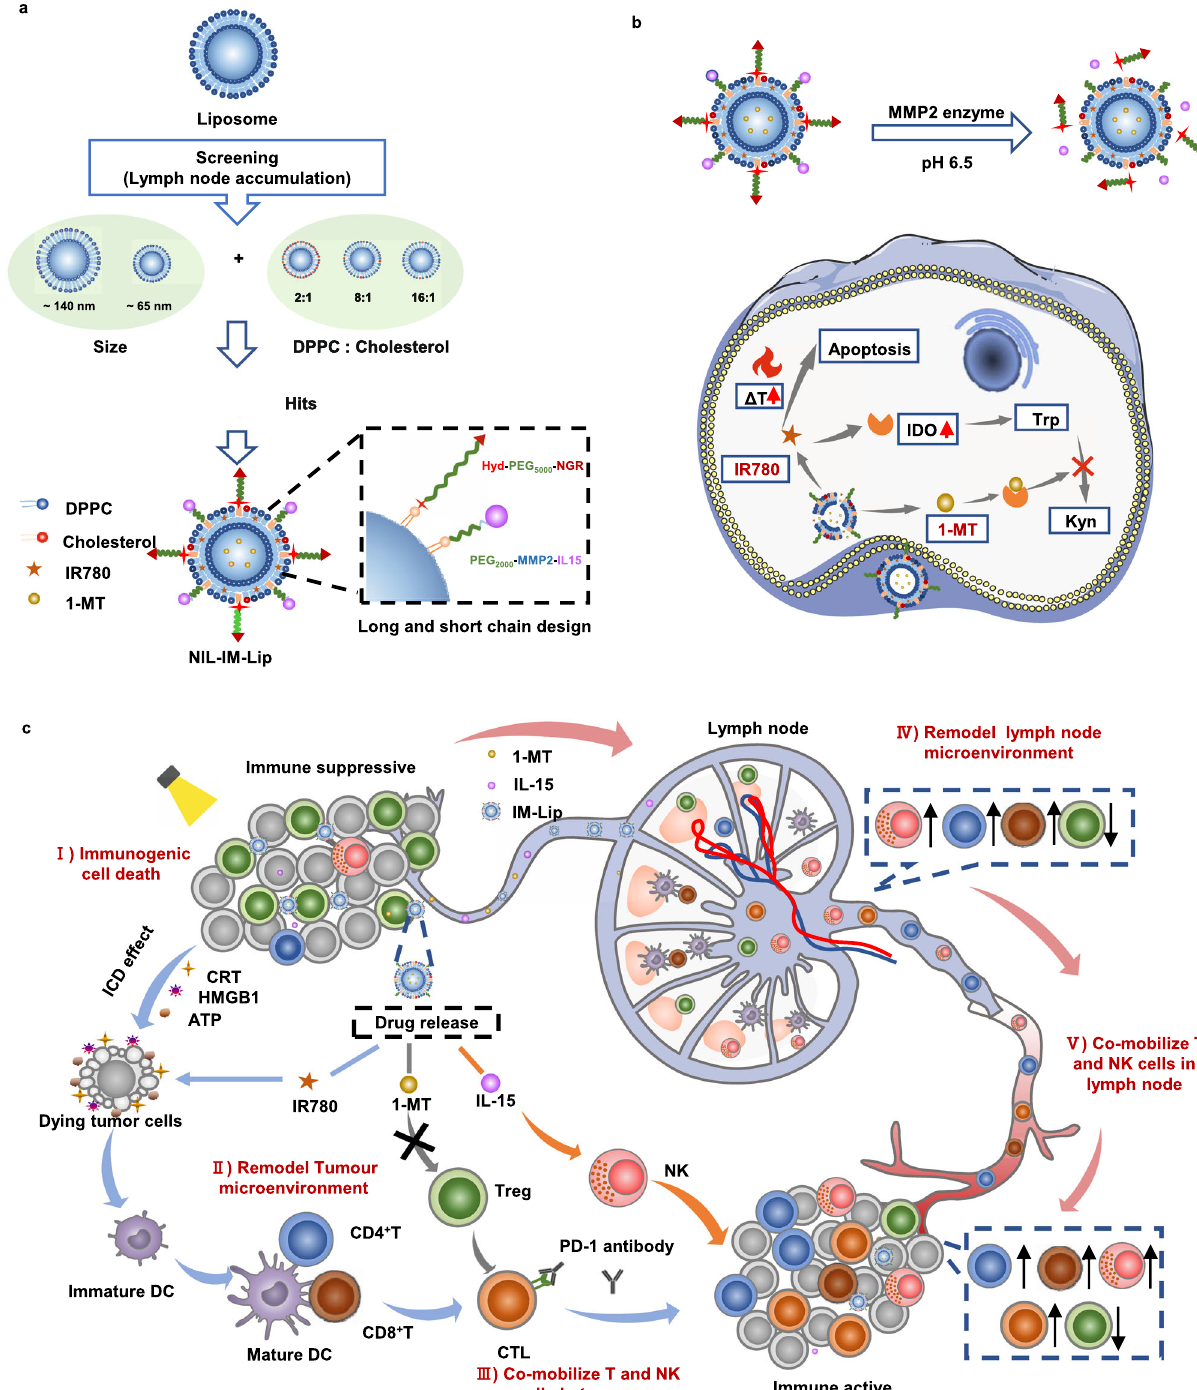
Fig. 1 | Schematic illustration of nanoinducers that remodel the immunosup- pressive tumour-lymph node microenvironment to mobilize T and NK cells. a Screening the size and cholesterol mass ratio for LNs accumulation. The pH/ MMP2/temperature-sensitive nanoinducers (NGR/IL-15-IR780/1-MT-Lip, NIL-IM- Lip)werepreparedwithDPPC(temperaturesensitive),IR780,1-MT,DSPE-PEG 2000 - MMP2-sensitive pep-IL-15 (MMP2 sensitive) and DSPE-Hyd-PEG 5000 -NGR (pH sen- sitive). b After accumulationintumour tissues, the nanoinducersrelease IL − 15 and NGR,whicharethentakenupbytumourcells.IR780inducestumourcellapoptosis via hyperpyrexia and enhances the higher expression of IDO1. 1-MT inhibits kynurenine accumulation under photothermal therapy. c Nanoinducers can be